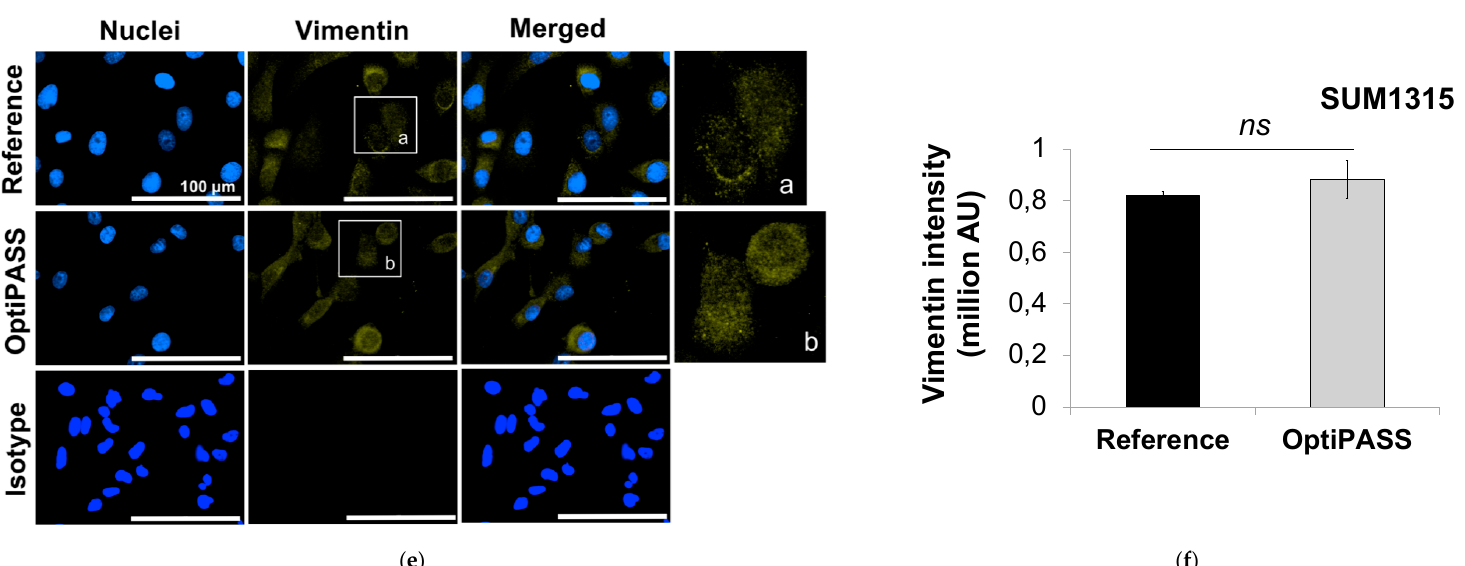
Figure 2. SUM1315 monolayer cell culture development with OptiPASS medium. ( a ) 2D proliferation rates: the number of adherent cells was counted with Cytation3MV plate reader (BIOTEK) after one, two, three, four and seven days of culture and normalized to cell counting at day one, n = 9, bars = s.e.m. ( b ) Cell metabolic activity monitoring: the metabolic activity of adherent cells was quantified with resazurin test for seven days and normalized to cell metabolic activity quantified at day one, n = 16, bars = s.d. ( c ) Cell repartition profile: cells cultured in reference medium or OptiPASS medium were harvested and counted with a blue trypan exclusion test. Three cell categories are represented: “floating” and “dead” cells were counted in the supernatant medium, and “adherent” cells were counted after trypsinization of the cellular carpet. n = 5, ns = non-significant difference with student t -test ( d ) Cellular carpet morphology in phase contrast imaging: each well of the six-well microplate was imaged at day one, two, three, four and seven (confluence) with Cytation3MV plate reader. Images (M = 4X) were stitched to allow an overview of the all well. Well area = 9.6 cm 2 . ( e ) Vimentin immunofluorescent staining: cells cultured in reference or OptiPASS medium were immunoassayed for vimentin expression with Cytation3MV (GFP and Cy5 filters). The isotype control is the negative control for vimentin expression. Scale bar = 100 µ m, blue = nuclei, yellow = vimentin. ( f ) Vimentin intensity quantification per cell (AU, error bars = s.d.). ns = non-significantly different, ***** = p < 0.00001, two-sided Student’s t -test comparison.